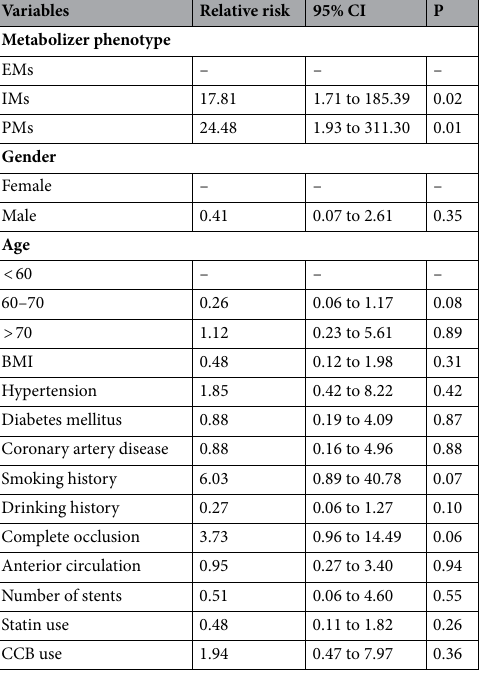
Table 4. Risk factors for the primary endpoints. EMs, extensive metabolizers; IMs, intermediate metabolizers; PMs, poor metabolizers; BMI, body mass index; CCB, calcium channel